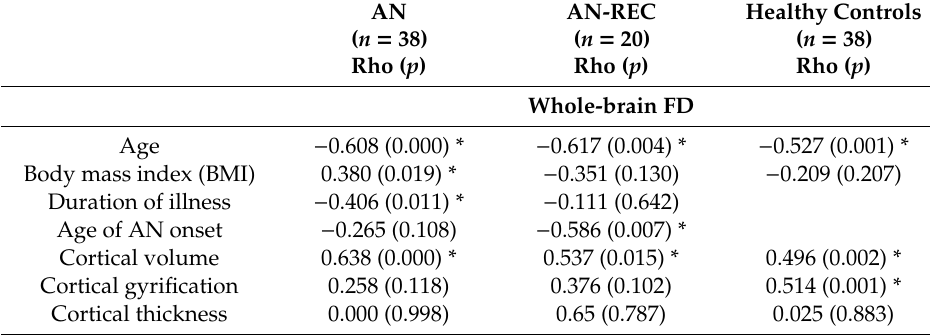
Table 3. Correlation between whole-brain (cortical ribbon) FD and clinical variables within each group.